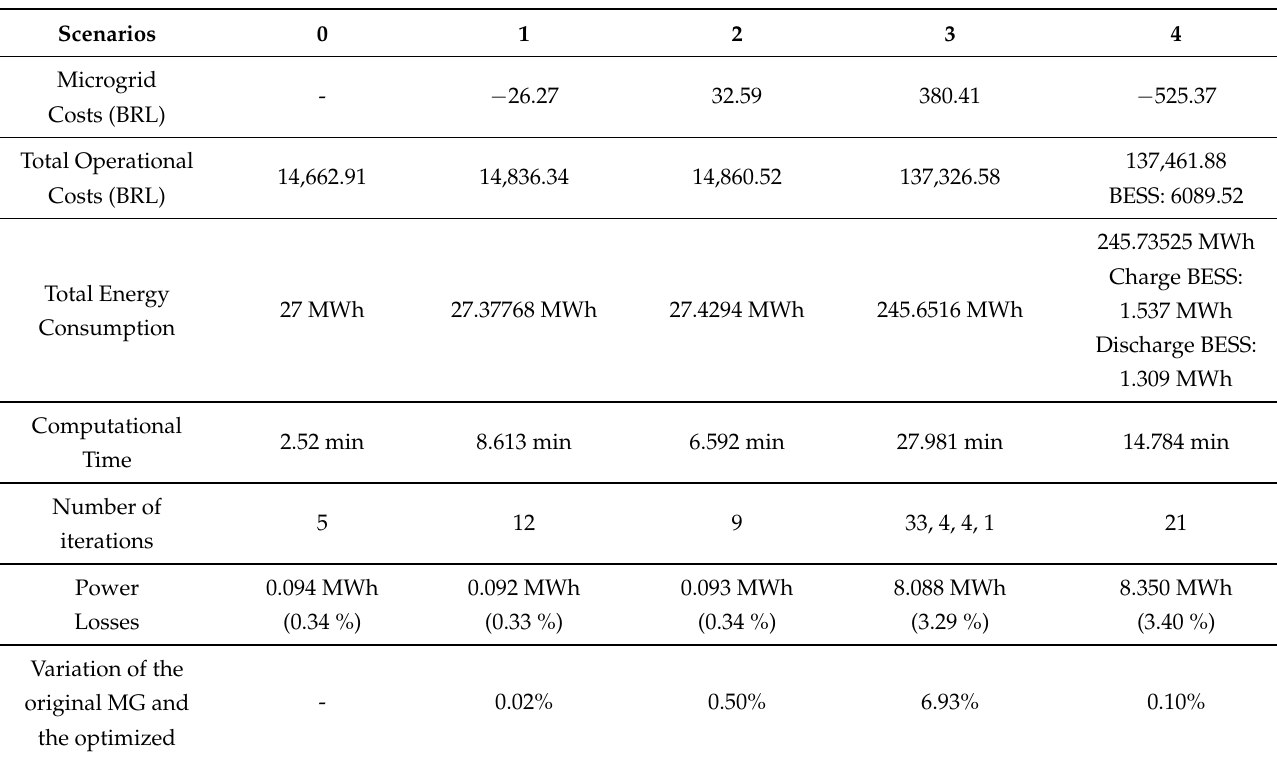
Table 2. Comparison of the results of the scenarios